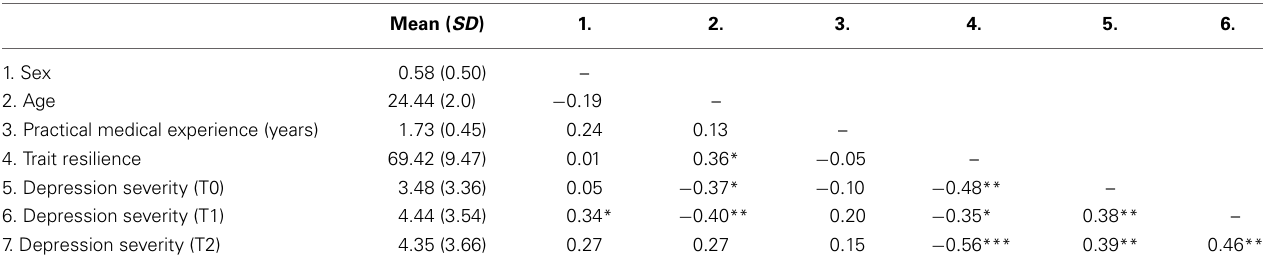
Table 1 | Correlations among and descriptive statistics for key study variables ( N =